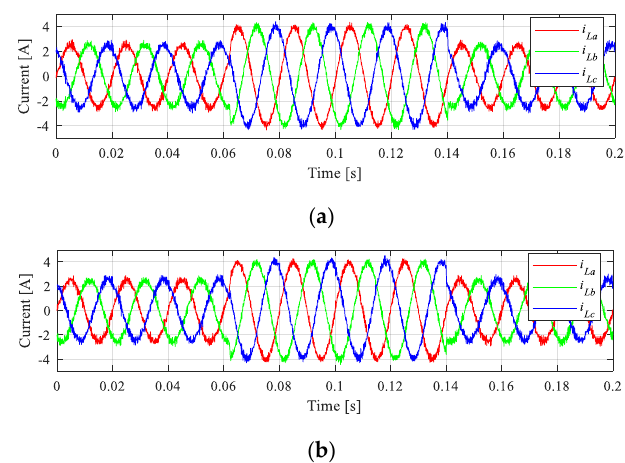
Figure 12. Experimental result: three-phase load current for the FS-MPC in ( a ) αβ -frame and ( b ) dq -frame.